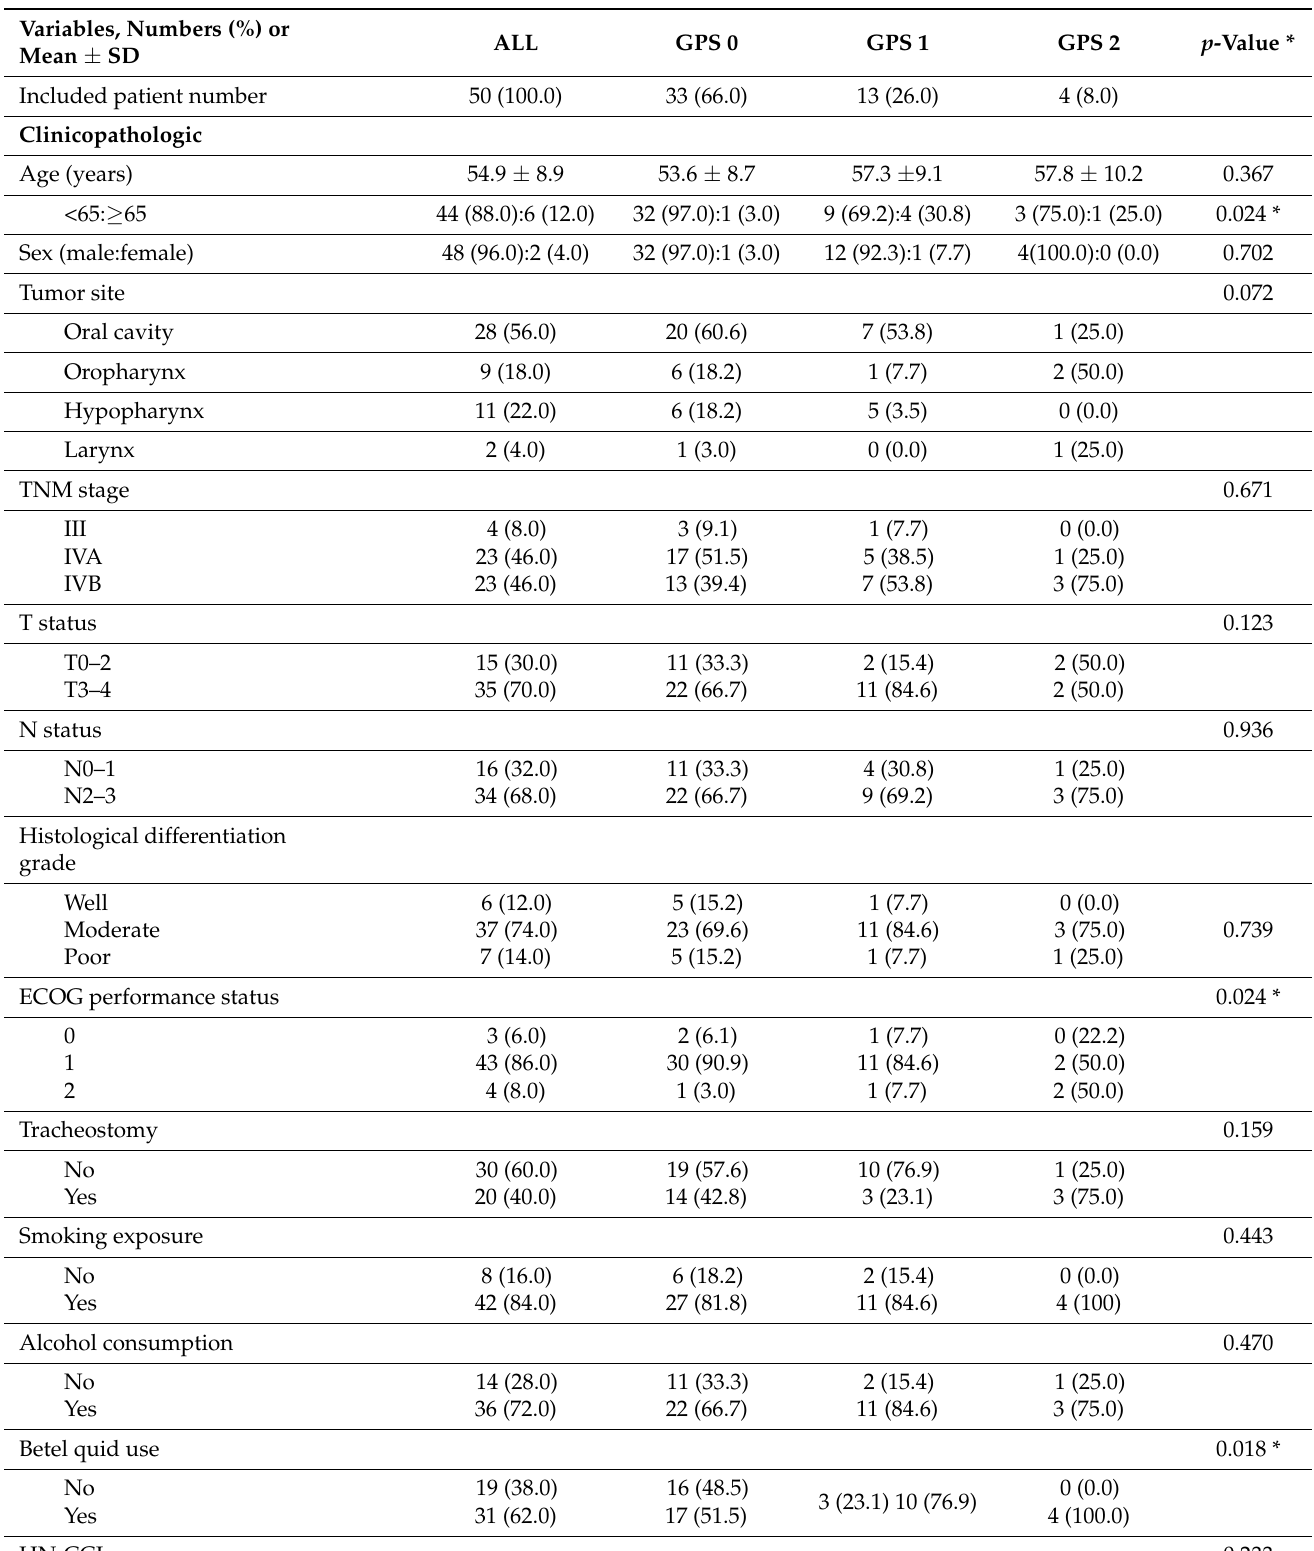
Table 2. Clinicopathologic variables, biochemical and nutrition-inflammation data, anthropometric and body composition characteristics, and serum HLOP metabolite of 50 patients with LAHNSCC stratified by GPS